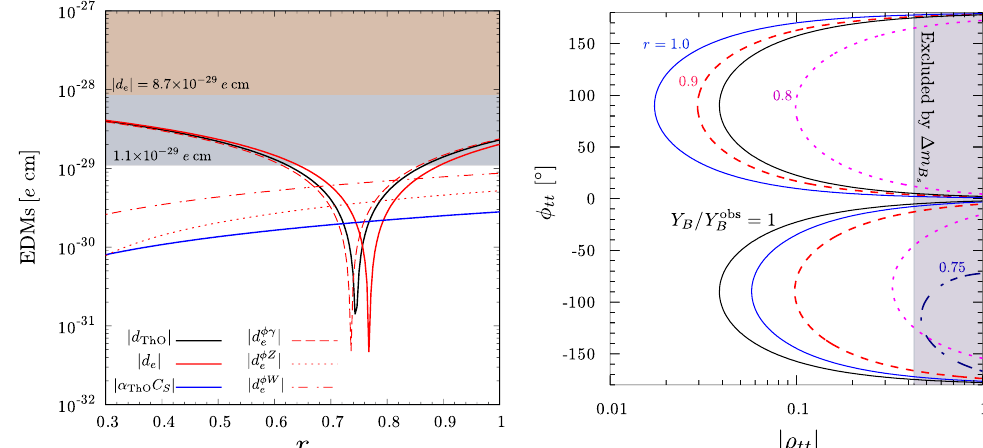
d ThO Figure 5. ( Left ) and its components vs r , as defined in Equation (22). We take | | = 500 GeV, with ACME bounds over- Re ρ tt = Im ρ tt = 0.1, c γ = 0.1 and m H = m A = m H − ± laid. ( Right ) 2 σ -allowed region of d ThO with r = 1.0 (blue, solid), 0.9 (red, dashed), 0.8 (magenta, dotted) and 0.75 (navy blue, dot-dashed), respectively. The region to the right of the black solid = 1, is allowed. The gray shaded region is nominally excluded by B s – ¯ B s contour, Y B / Y obs B